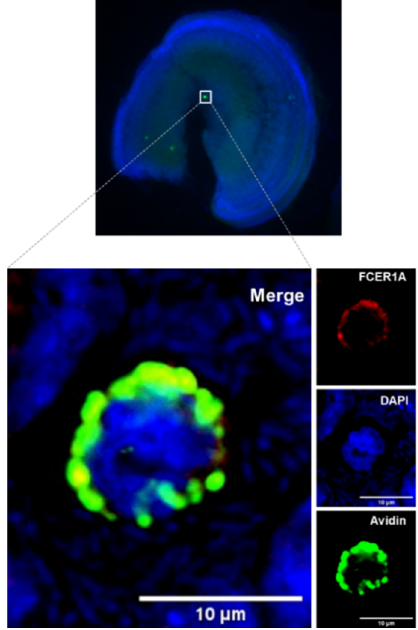
Figure 3. Cochlear MCs express the high-affinity immunoglobulin epsilon receptor subunit-alpha (Fc ε RI α ). The image shows a cochlear explant of p3 mouse stained with an antibody against Fc ε RI α (red), avidin (green), and DAPI (blue).